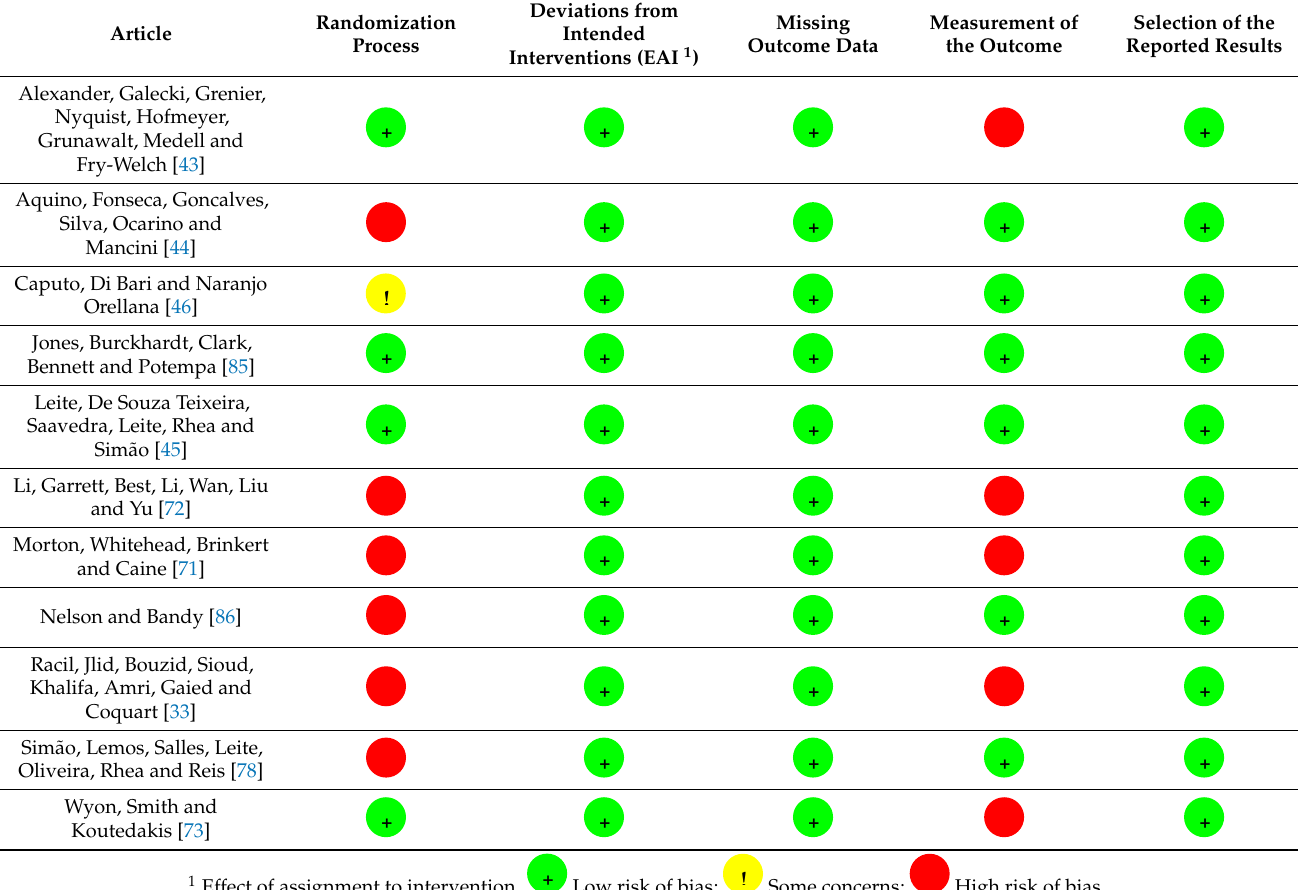
Table 2. Assessments of risk of bias (Cochrane’s RoB 2).